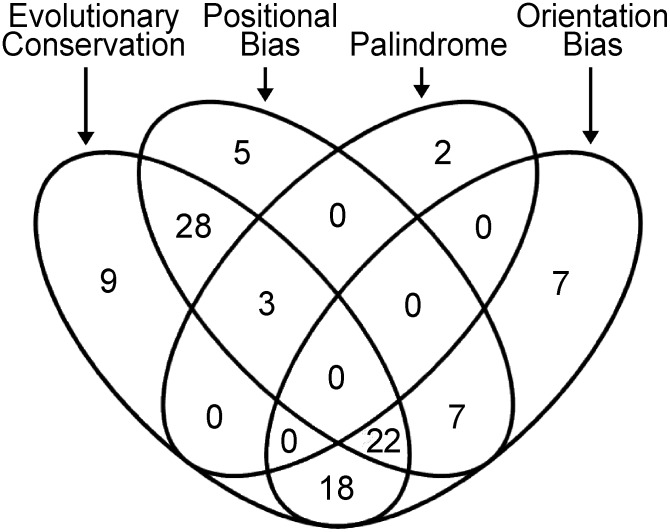
Summary of results from analysis of evolutionary conservation, positional bias, forward/reverse directionality, and palindrome analysis.Of the 103 predicted TFBSs, 101 show at least one of these features and are included in the figure.